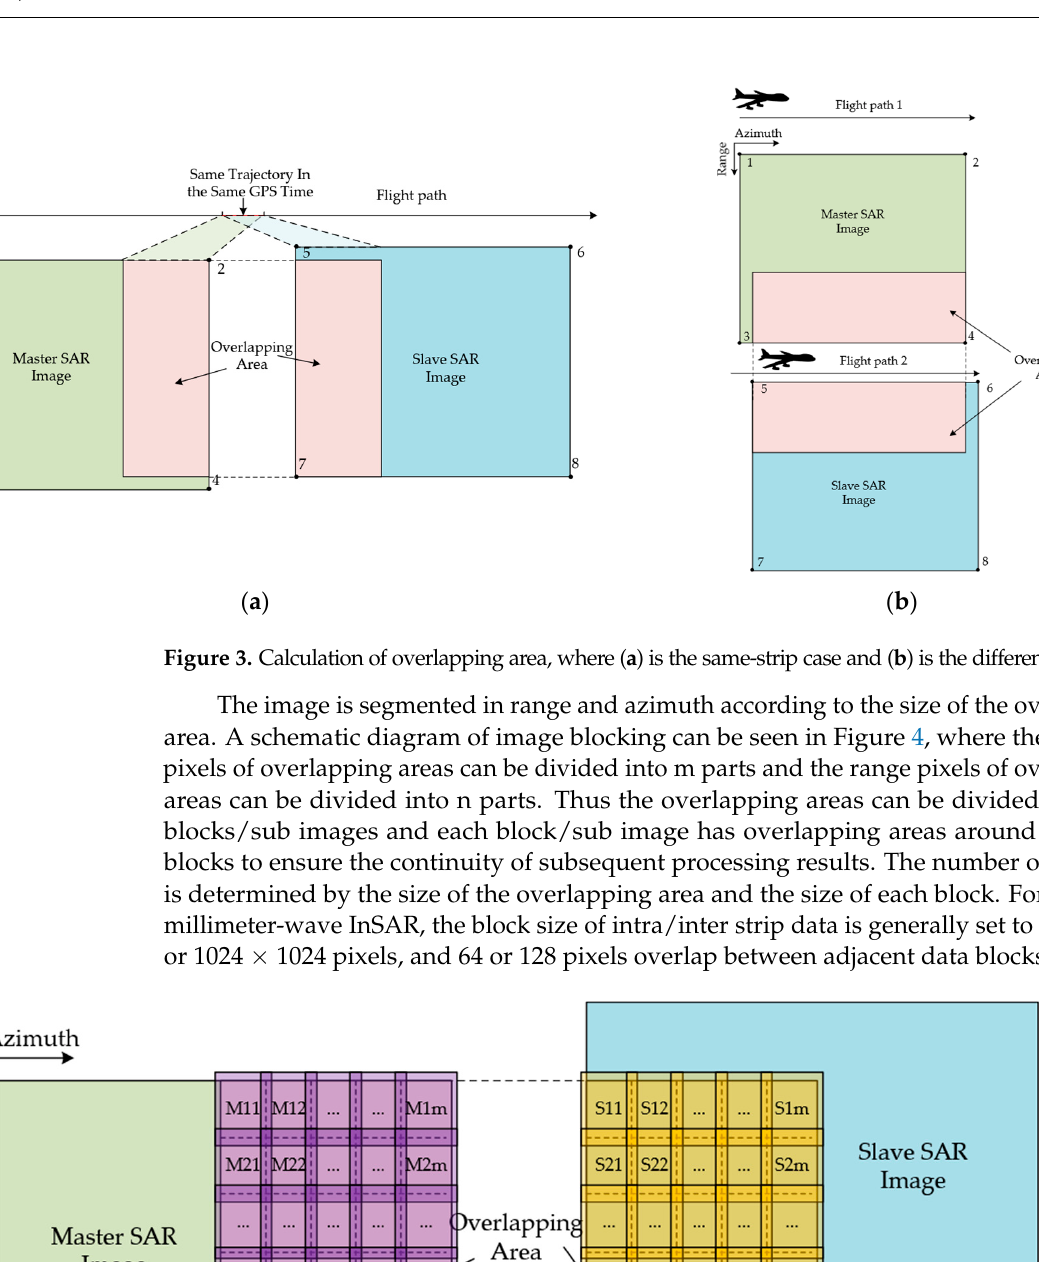
Figure 5. Diagram of SAR + SIFT + RANSAC processing flow.